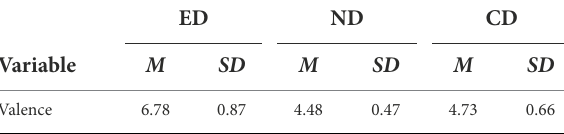
TABLE 1 Mean valence ratings and standard deviations for design ( n = 15).